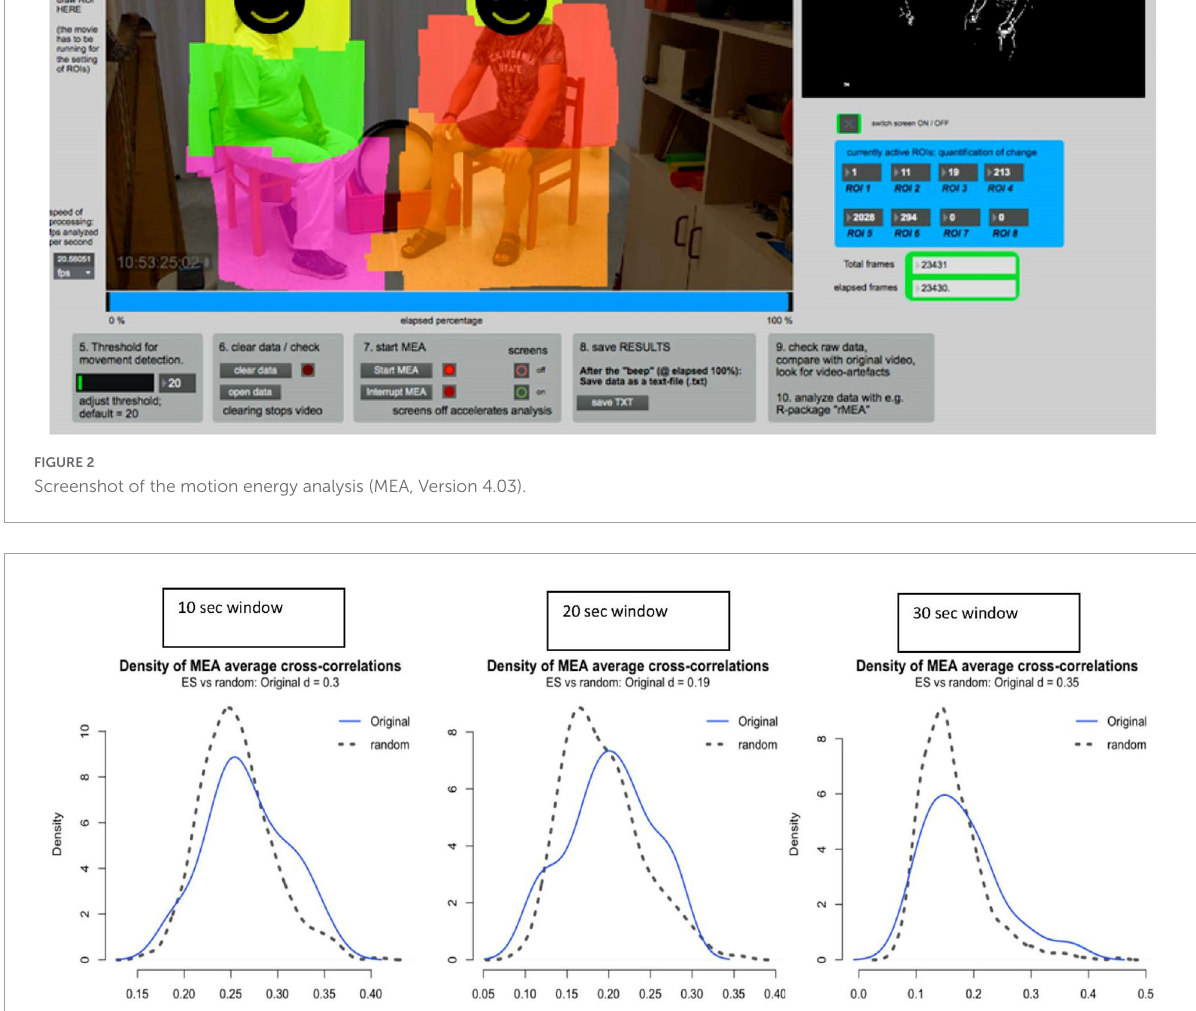
of the analyzed segments in our sample. Within subject shuffling would have provided insufficient recombinations, if the segment size was kept identical in both real and pseudo interactions (Ramseyer and Tschacher, 2010; Moulder et al.,